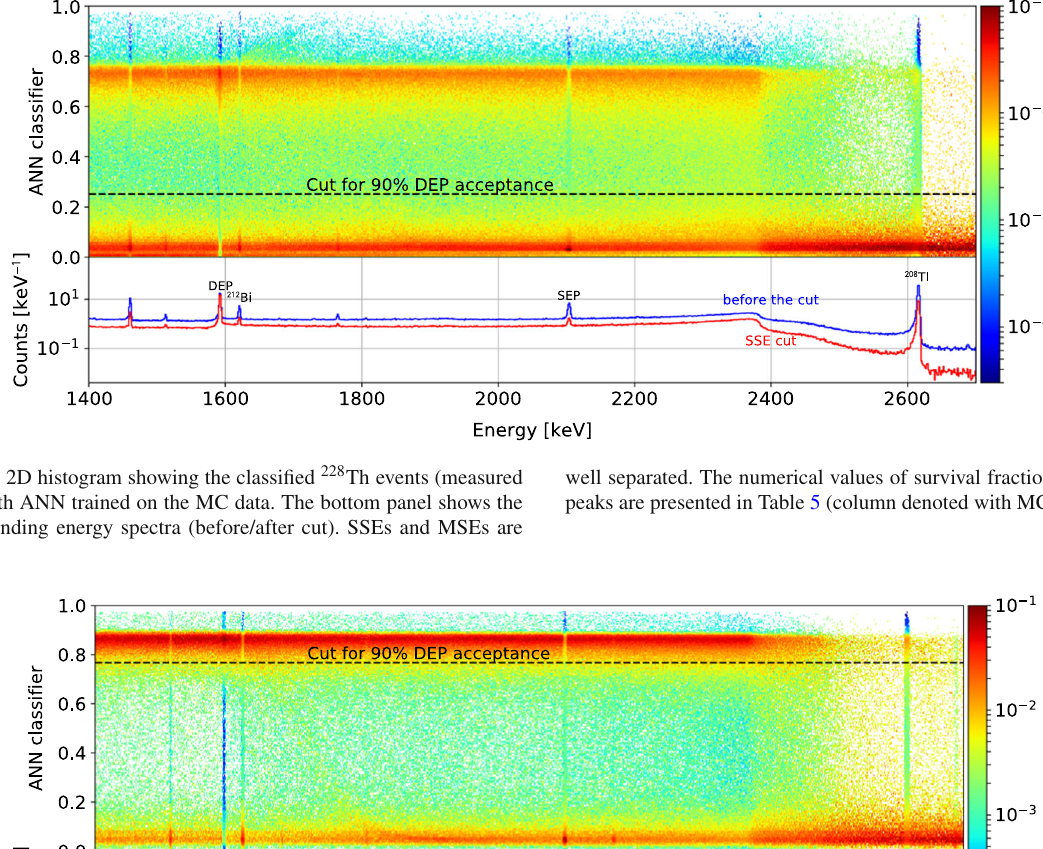
Fig. 21 2D histogram showing the classified 228 Th events (MC data) with ANN trained on the measured data. The acceptances for various peaks are included in Table 5 (column denoted with Meas./MC) Fig. 22 Close-up of the 228 Th (ANN trained on MC pulses, real data classified) spectrum before and after the cut rejecting MSEs (the same spectrum as in the bottom panel of Fig. 20), showing the effect of the PSA method on peaks consisting of events of different types. Suppression of MSEs in SEPs and FEPs is clearly visible, while SSEs in the DEPs are mostly